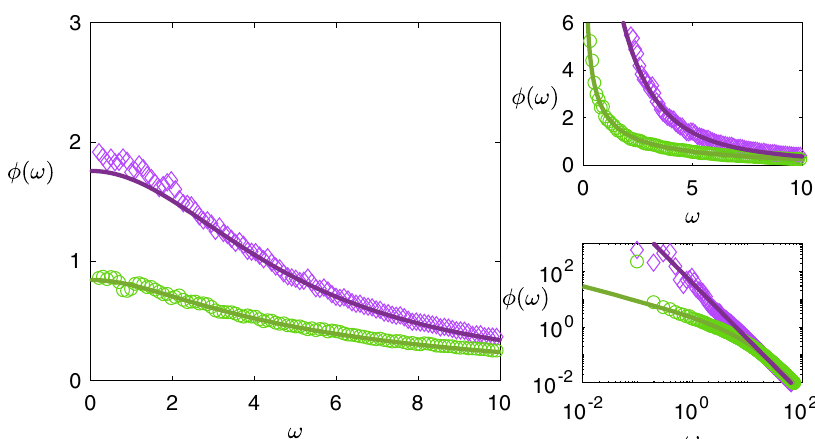
Fig. 2 Fluctuation spectra in systems with lower predator-prey densisty. Left: stable systems with γ = 0 (purple diamonds) and γ = 1 (green circles) have similar fl uctuation spectra, with a higher proportion of predator – prey interactions in the γ = 0 case associated with higher overall excitation. Right upper: near instability a pole emerges at ω = 0, corresponding to baseline drift in marginally stable systems. Right lower: In log – log axes we see the different nature of the pole for mixed ( γ = 0, purple diamonds) communities compared with those with only symmetric interactions ( γ = 1, green circles). For γ = − 1, see Fig. 1, left panel. Common parameters are N = 1000, c = 50, σ 2 =